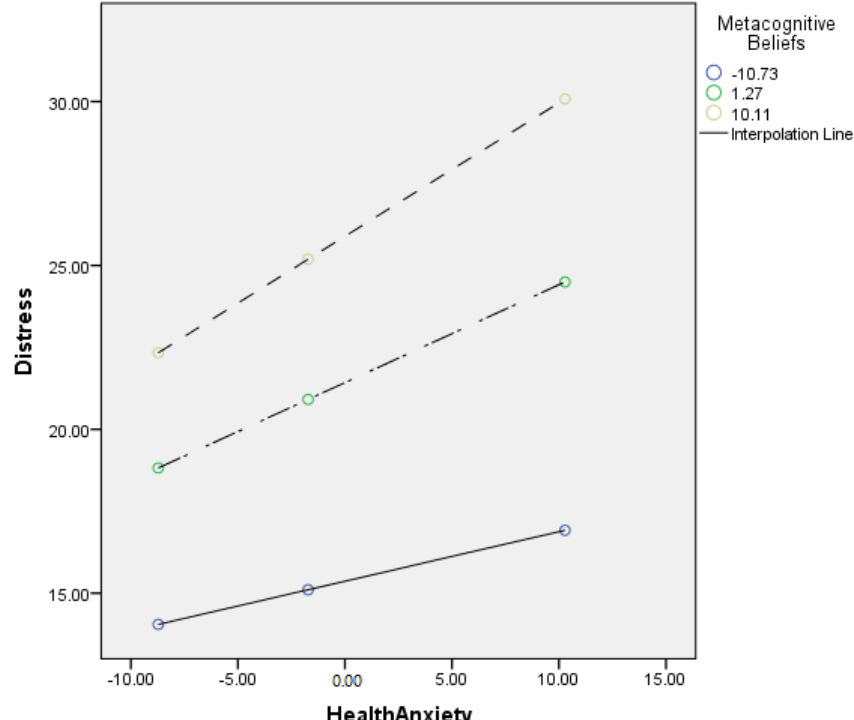
anxiety and Figure 3. Graphical presentation of the moderating role of metacognitive beliefs between health anxiety and distress.